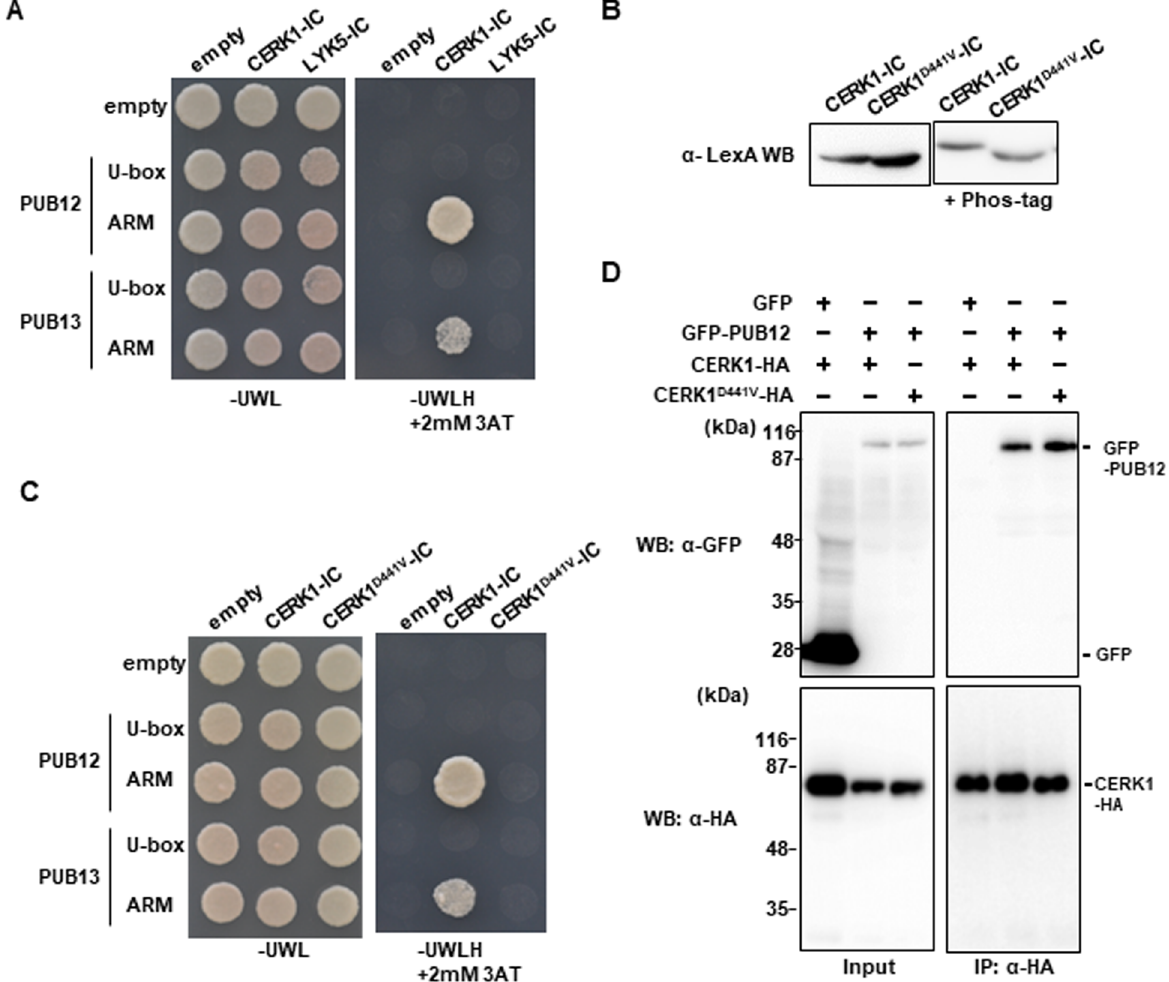
Fig 2. Interaction of PUB12 and PUB13 with CERK1 depends on its kinase activity. (A) PUB12 and PUB13 interact with the intracellular domain(IC) of CERK1, but not LYK5 in the yeast two hybrid experiment. The growth of yeast colonieson plates (-ULWH) lackinguracil (U), leucine(L), tryptophan (W), and histidine(H) with 2 mM 3-aminotriazole (3-AT) indicatesa positive interaction.(B) Immunoblot analysisof yeast extracts containing LexA fusion proteins. Total proteins were preparedfrom the yeast cells used for the two-hybridassays in Fig 1B. Proteins were subjectedto Phos-tag SDS-PAGE (right) or SDS-PAGE (left). Gels were analyzedby Western blotting with α -LexA. (C) PUB12 and PUB13 interact with CERK1-IC, but not the kinase-inactive mutant (CERK1 D441V ) in the yeast two hybrid experiment. (D) Co-immunoprecipitation assays show that PUB12-GFP forms a complexwith the kinase-activeand inactive forms of CERK1 in Nb leaves.